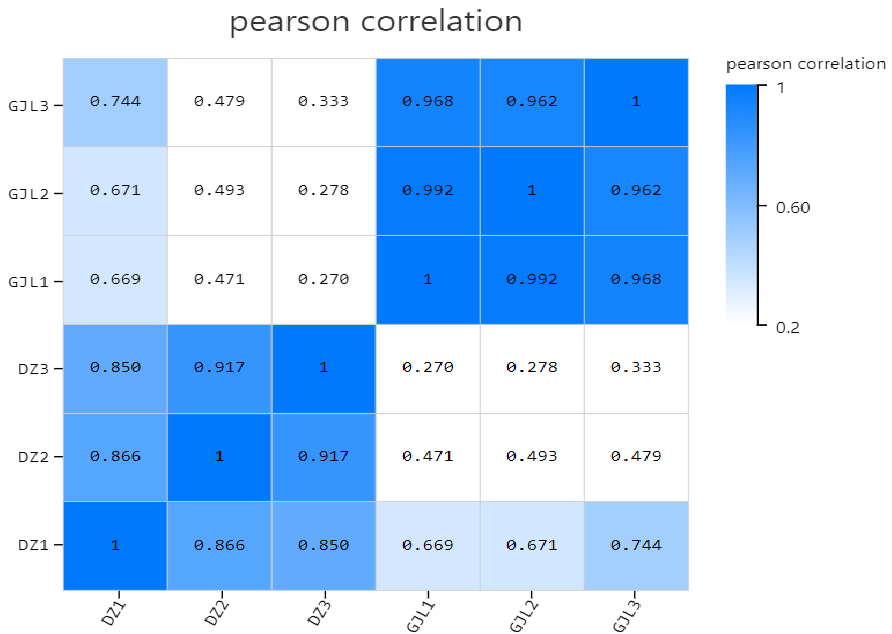
Table 1. Quality of RNA − seq data from toxicity of tritiated water samples. Total Raw Sample